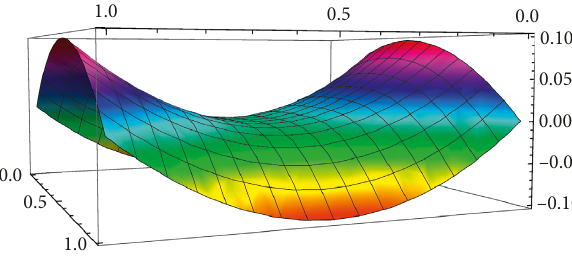
Figure 18: Second order ( t � 0.007s).